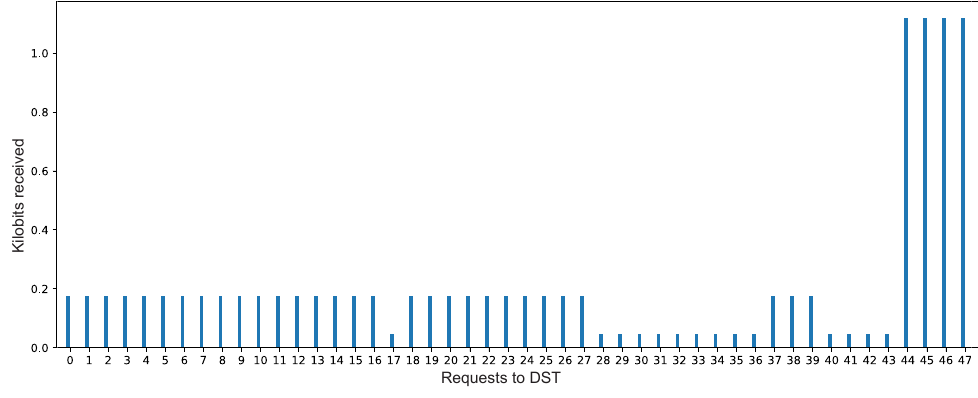
Figure 10. Kilobits received in the requests.